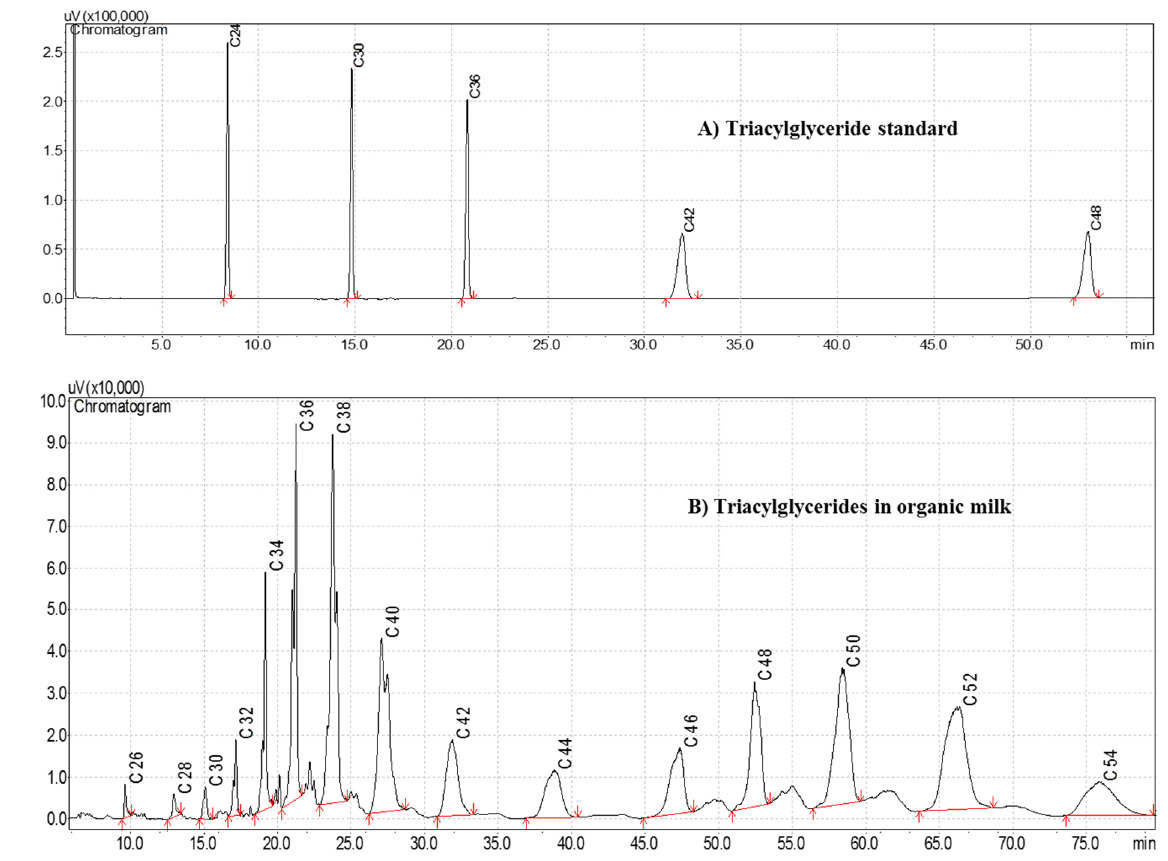
Figure 1. Chromatograms of triacylglycerides, injection volume 1.2 µL. ( A ) chromatogram of the triacylglyceride standard; ( B ) chromatogram of triacylglycerides from organic milk fat produced in Tecpatán, Chiapas.